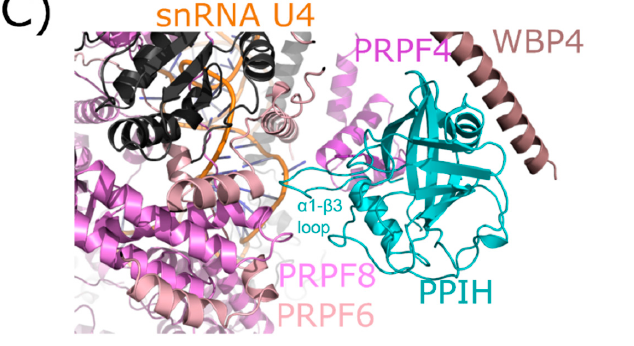
Figure 4. The interaction between PPIH and PRPF4 seen in solution is preserved in early spliceosomes. ( A ) The complex between a small peptide from PRPF4 and the PPIH isomerase domain is shown in cartoon representation (PDB ID: 2MZW) [40–42]. Key catalytic site residues are highlighted, and in the right panel the high-affinity interaction between Phe122 and the α 1– β 3 loop of PPIH is shown. In ( B ), a table summarizing the high- and low-affinity sites between PRPF4 and PPIH. Below, a model of the proposed function of the high- and low-affinity sites. Panels ( A , B ) are modified from their original form in [32]. ( C ) The neighborhood around PPIH in the B complex human interactions with WBP4, PRPF6, and PRPF8 are highlighted. U4 snRNA is within 10 Å of PPIH and is labeled. Proteins in dark grey are further than 10 Å away from PPIH and are not candidates for direct